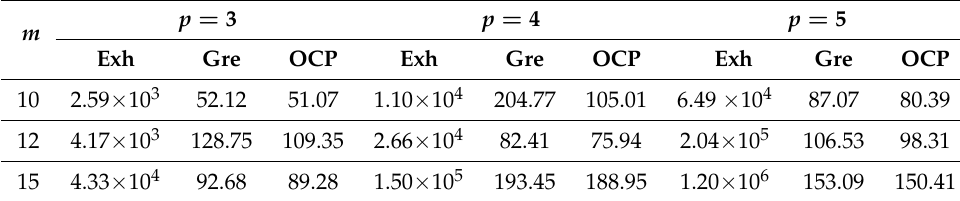
Table 3. Runtimes of Three Methods (s).